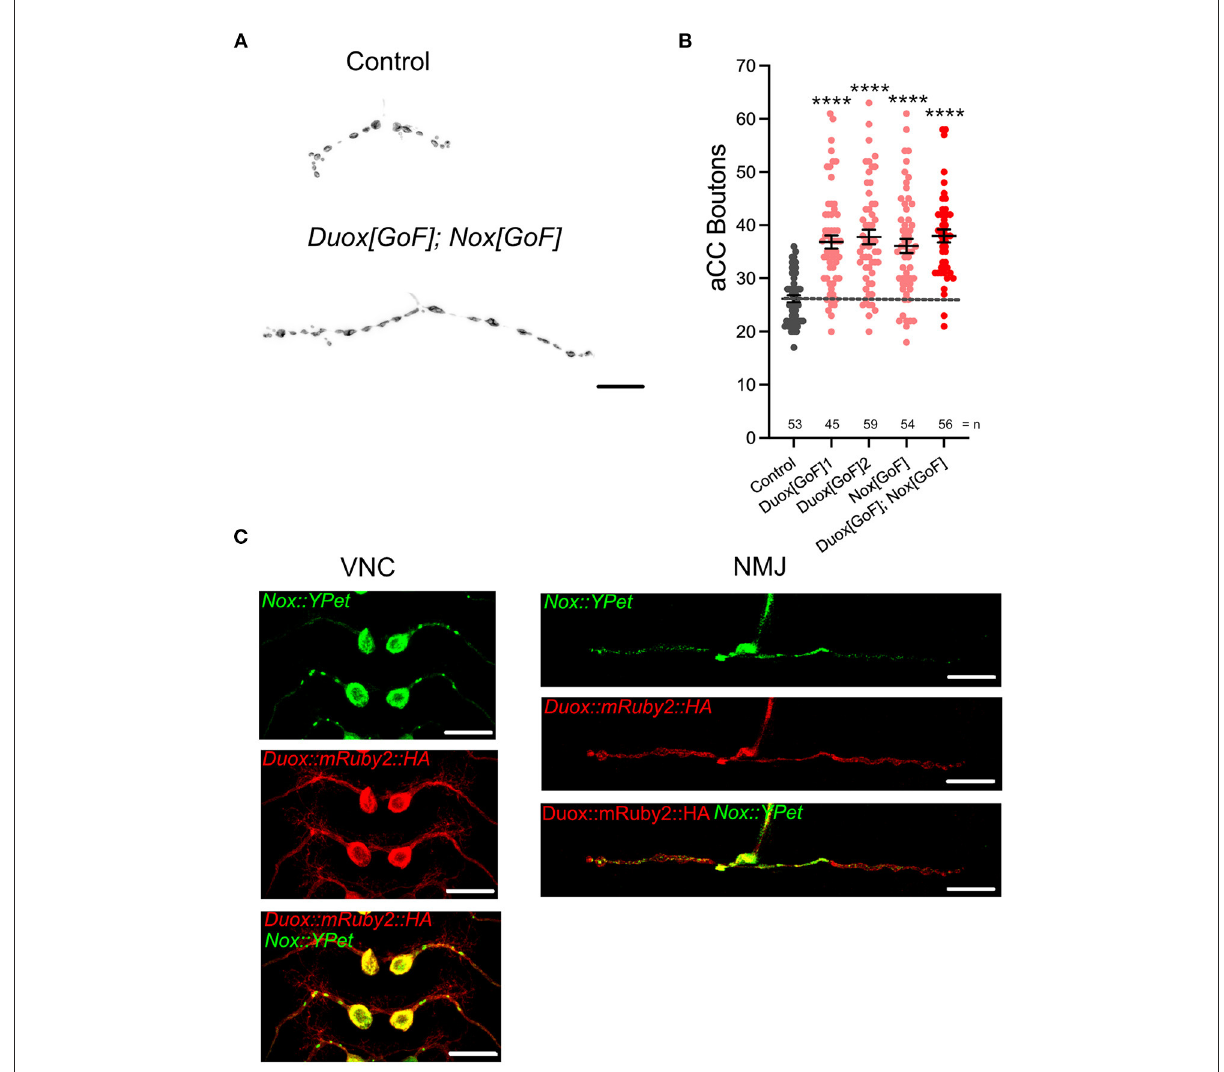
FIGURE2 dDuox or dNox activity is sufficient for mediating structural changes at the NMJ. (A) Representative images of aCC presynaptic terminals on muscle DA1 from third instar larvae (100h ALH) of control ( aCC/RP2-Gal4/ + ) and those overexpressing Duox[GoF] and Nox[GoF] . (B) Dot-plot quantification shows NMJ bouton number increases in response to cell-specific over-expression of NADPH oxidases. (C) Localization of tagged Duox and Nox transgenes in neurons: representative confocal micrograph images of aCC somata and dendrites in the ventral nerve cord (VNC) and aCC presynaptic terminals at the DA1 muscle in third instar larvae (72h ALH), showing subcellular localization of tagged over-expressed Duox::mRuby2::HA (in red) and Nox::YPet (in green). Mean ± SEM, ANOVA, **** p < 0.0001. Comparisons are made with the control group. Scale bar = 20 µ